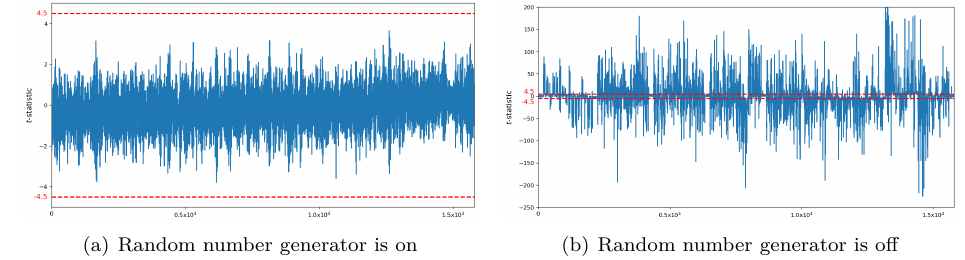
Figure 10: Security order d = 1, parameters are distinct nonzero values.